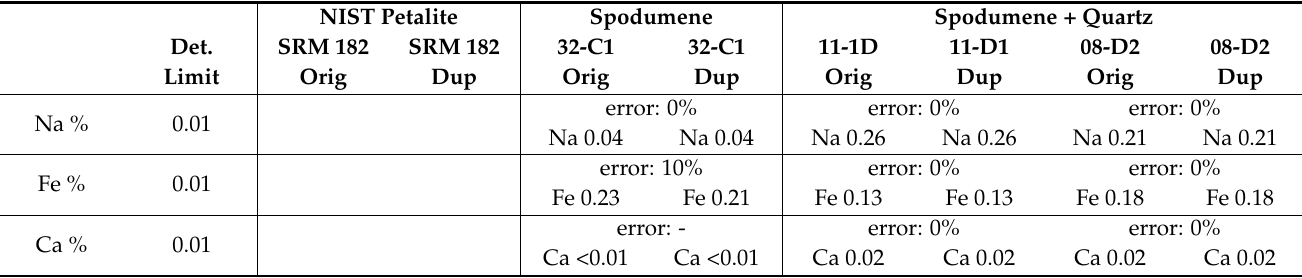
Table 5. ICP-MS errors from the duplicates made in Actlabs for the trace-elements of K-feldspar, petalite, spodumene and quartz with the method 4 Acid “Near Total” digestion. NIST Petalite Spodumene Spodumene +